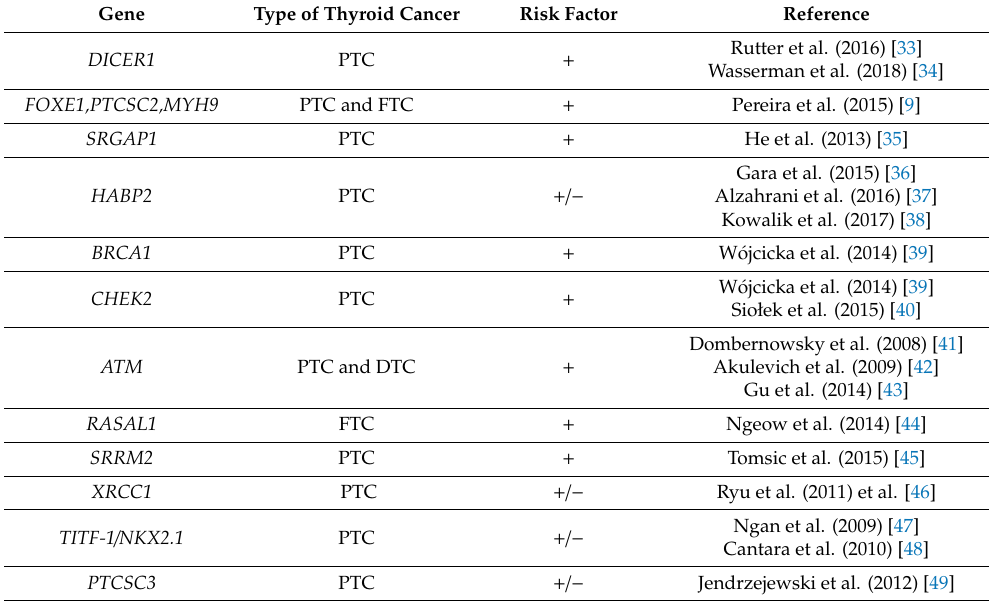
Table 2. Genes involved in the development of non-syndromic familial non-medullary thyroid cancers and the significance of the mutations in these genes as risk